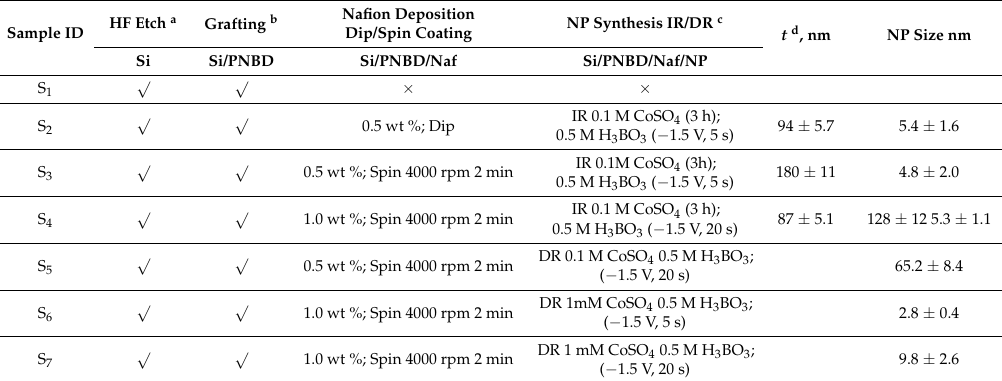
Table 1. Sample identification scheme and the processing conditions during each step.